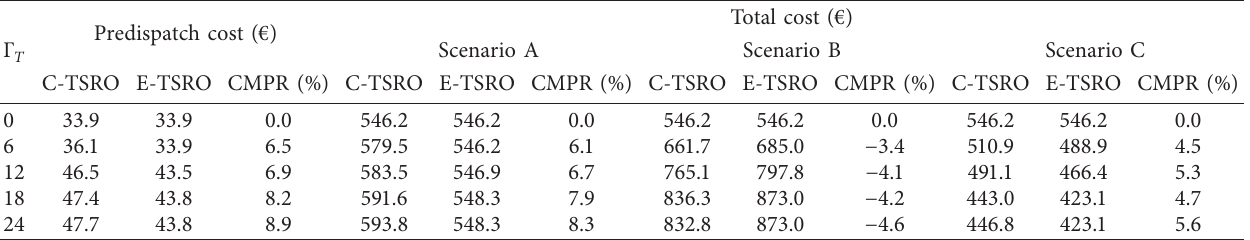
( Γ � 3 ) . T values S Total cost ( € ) Scenario A Scenario B Scenario C